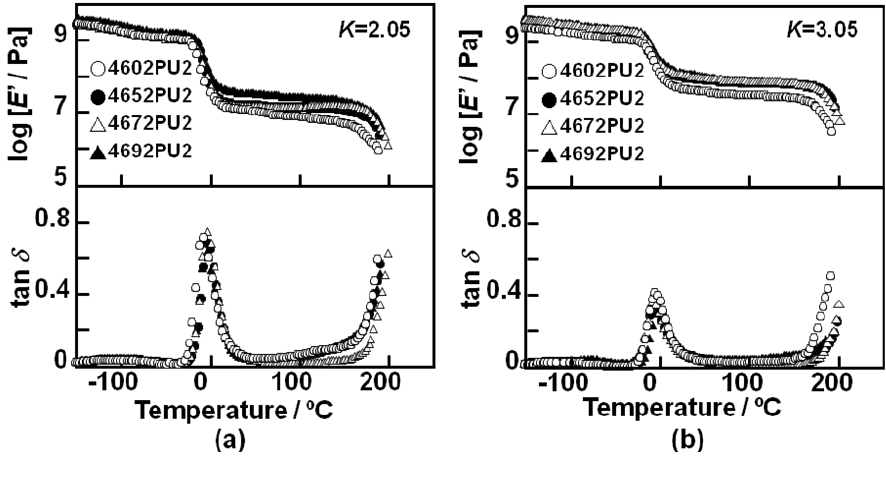
Figure 8. Temperature dependence of storage modulus, E ’, and loss tangent, tan  for PC-glycol-based PUEs. ( a ) K = 2.05 and ( b ) K =